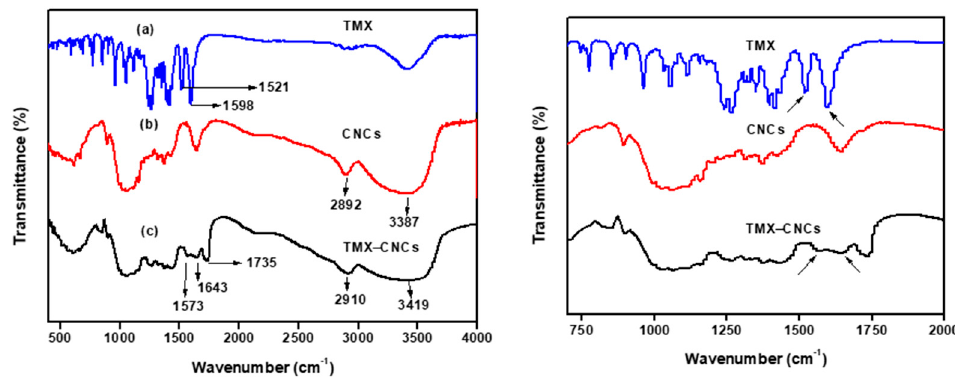
Figure 3. Fourier transform infrared (FT-IR) spectra of ( a ) TMX, ( b ) CNCs, and ( c ) nanoformulation (TMX-CNCs).